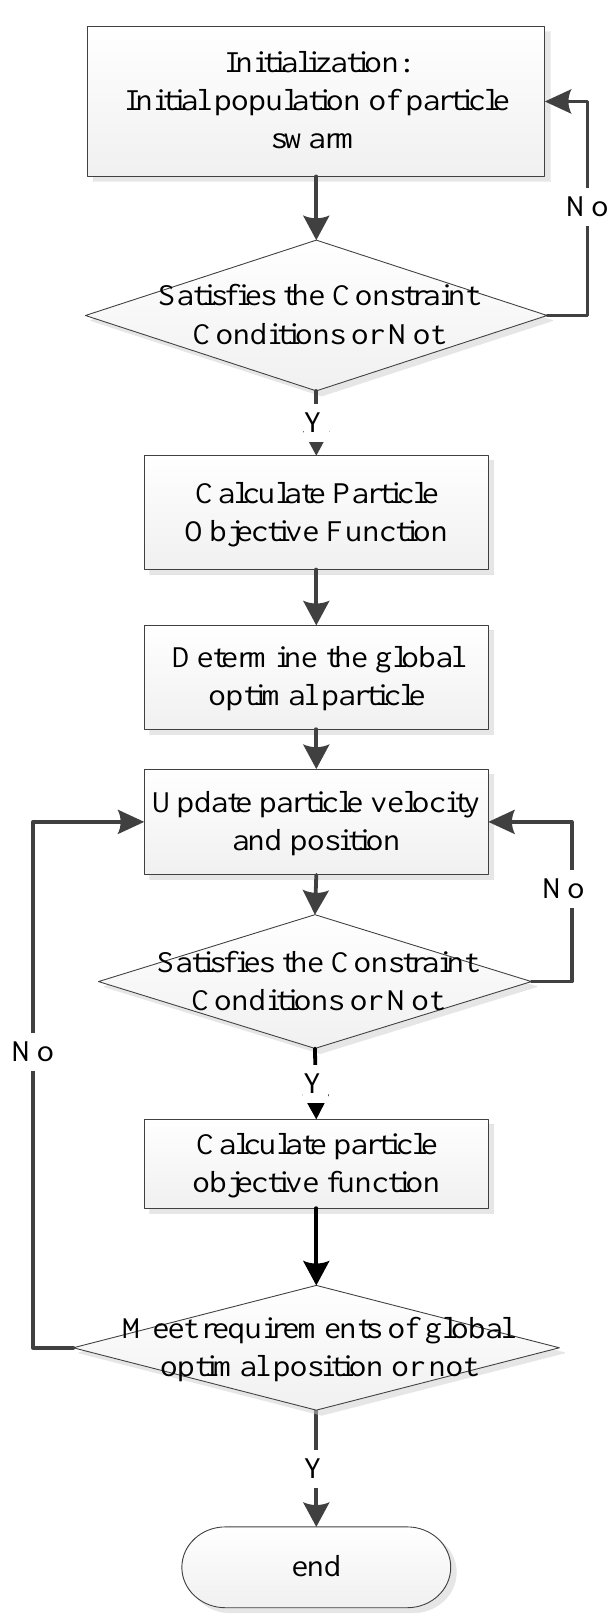
Figure 11. Algorithm flow chart.